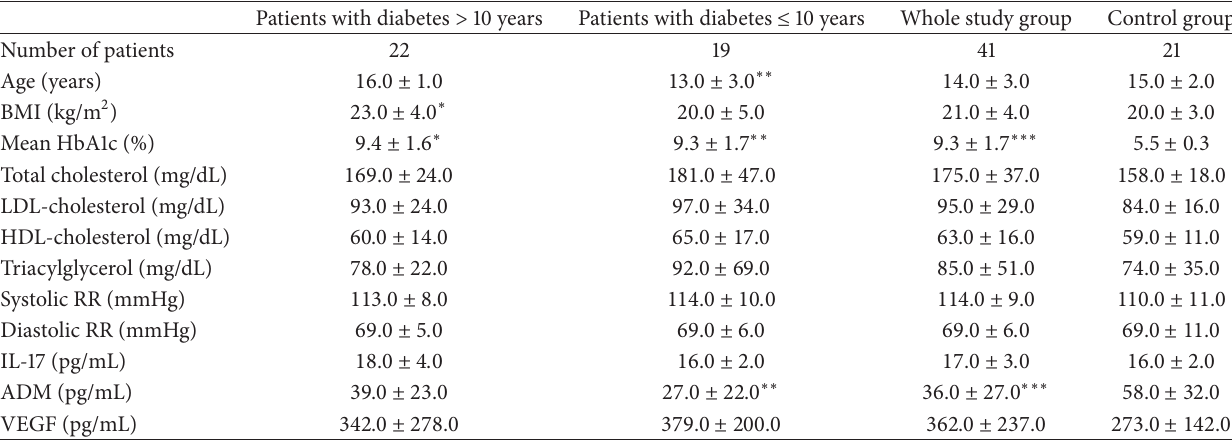
Table 1: General profile of the study